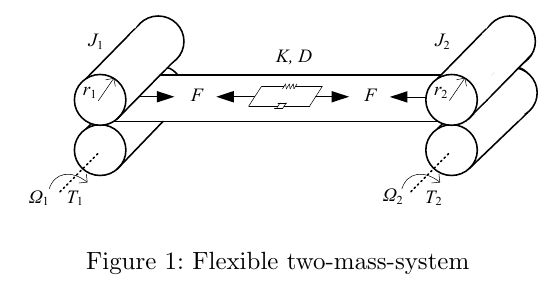
Figure 1: Flexible two-mass-system